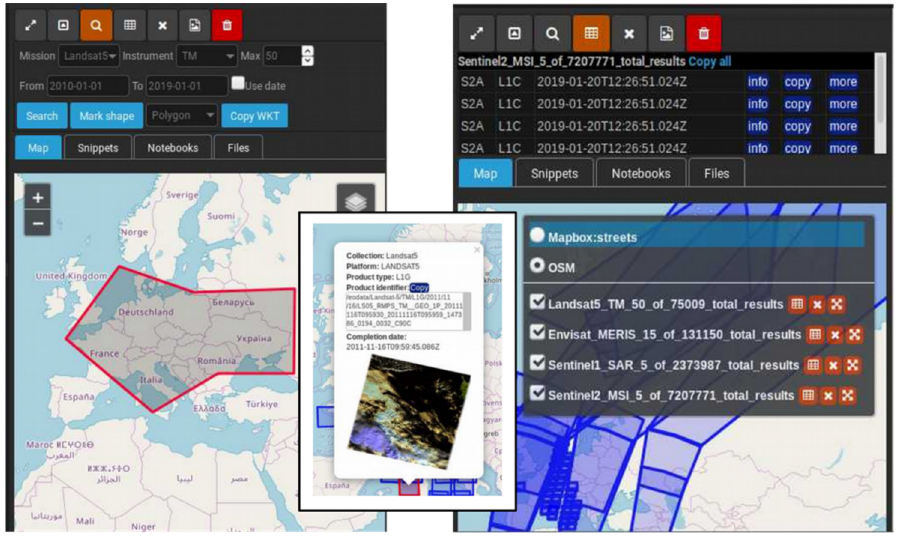
Figure 14. Data search in JupyTEP IDE.